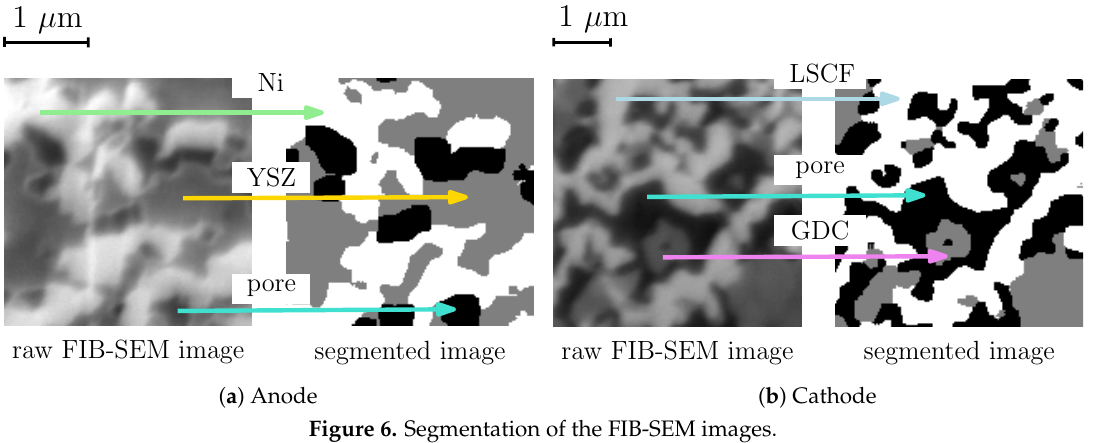
Figure 5. Semi-automatic segmentation procedure, on the example of the cathode FIB-SEM image.